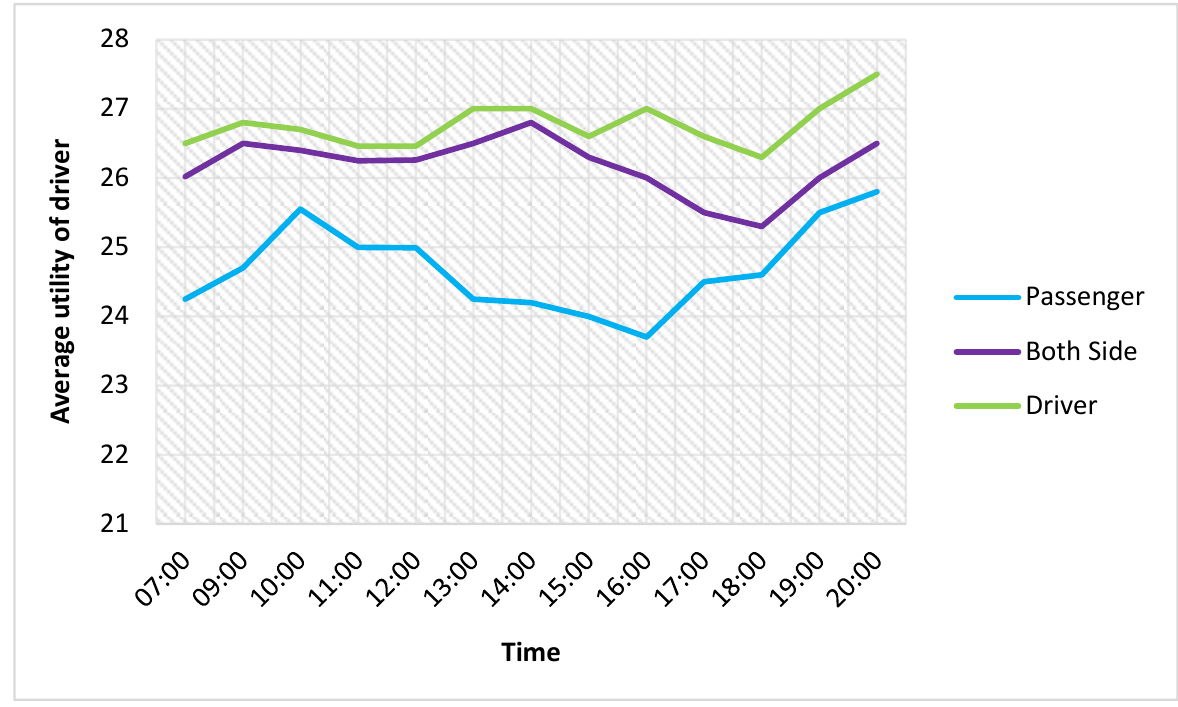
Figure 16. Comparision of the average utility of the driver.